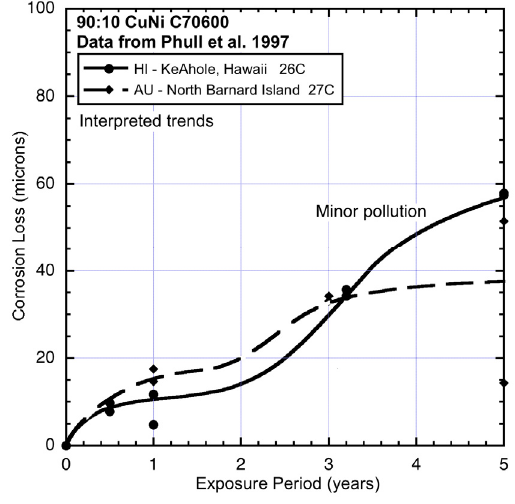
Figure 7. Data and interpreted trends for warm seawater sites HI and AU.